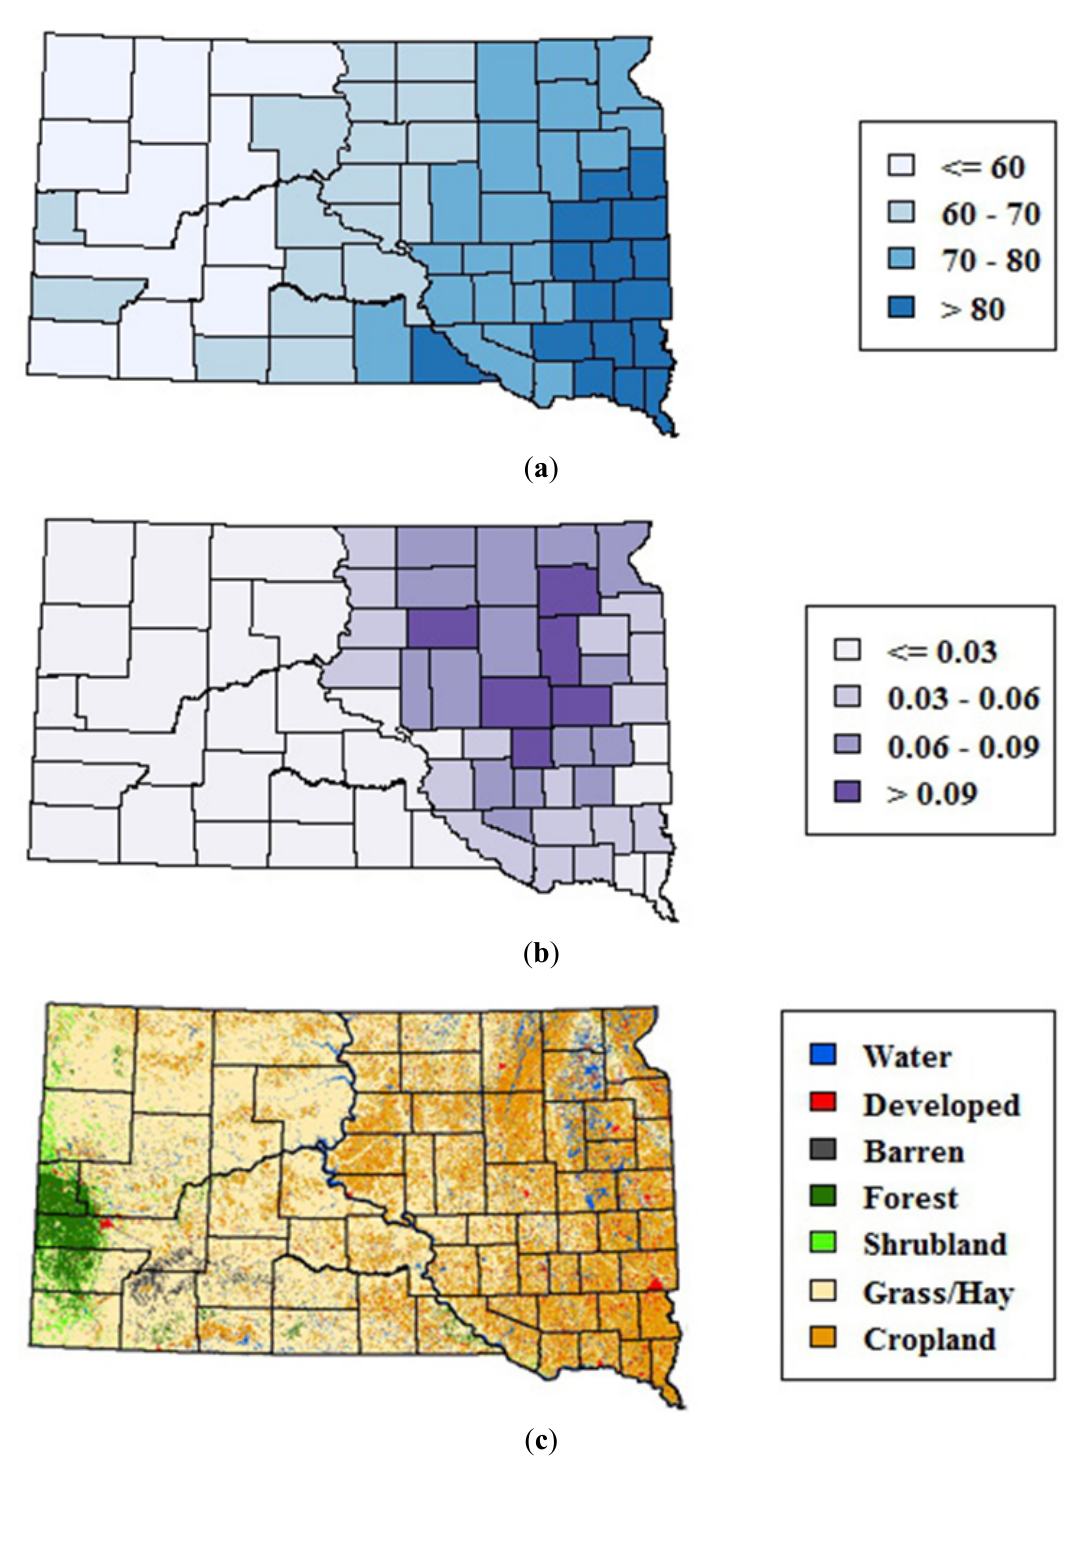
Figure 1. Environmental variability across South Dakota. ( a ) 1982–2011 mean monthly precipitation (mm) from May–September summarized at the county level ( b ) Emergent wetlands from the National Wetlands Inventory summarized as proportion of total county area, and ( c ) 2006 map of major land cover classes from the National Land Cover